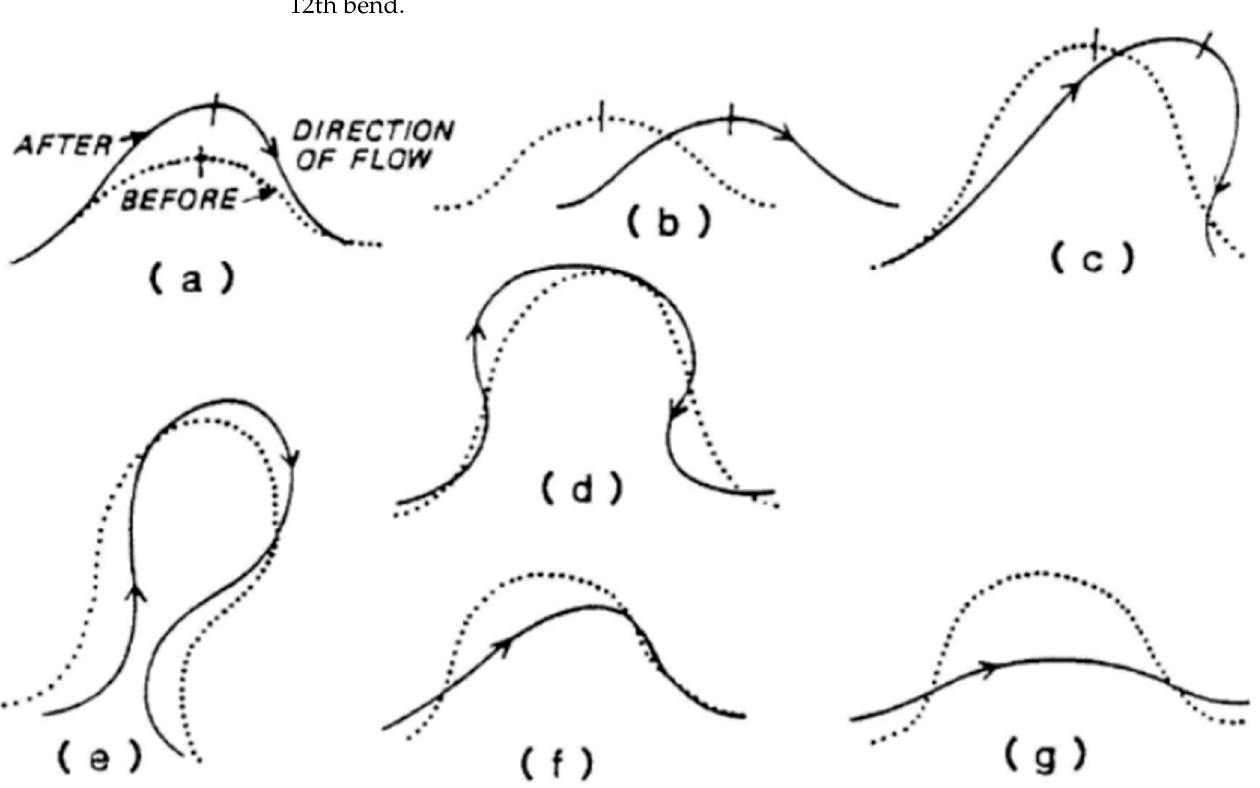
Figure 10. Different types of bend migrations: ( a ) extension; ( b ) translation; ( c ) rotation; ( d ) conversion to a compound loop; ( e ) neck cutoff by closure; ( f ) diagonal cutoff by chute; ( g ) neck cutoff by chute (extracted from Lagasse [36]). Table 3. Classification of meandering bend migrations in the lower Deduru